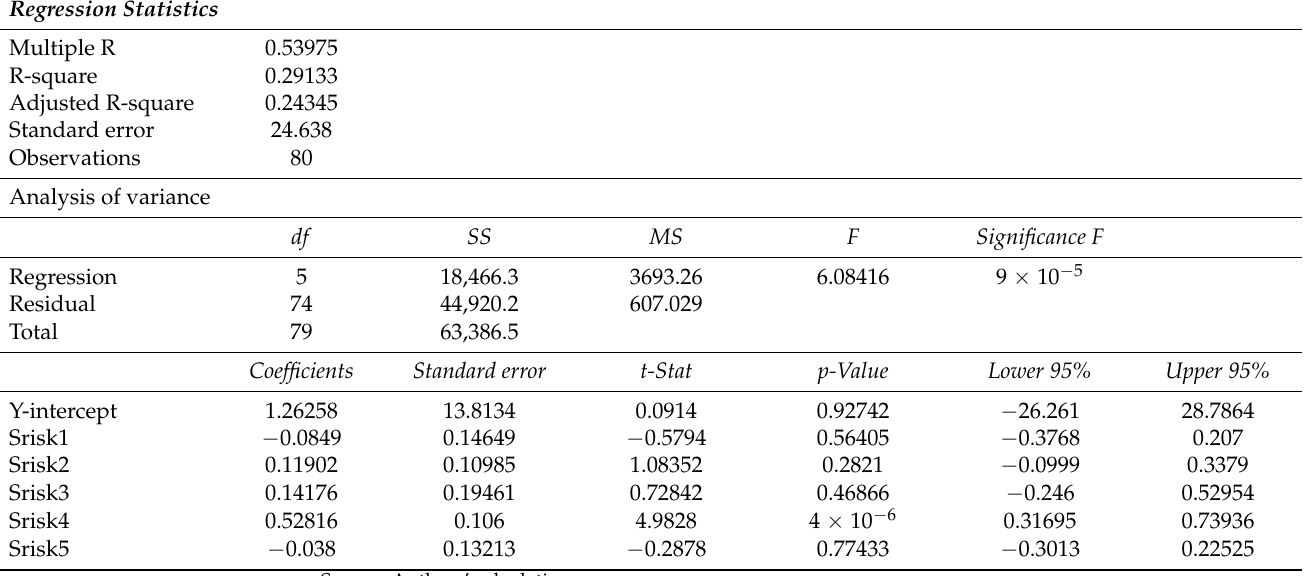
Table A11. Regression statistics of the dependence of Frisk 2 on social consequences of investments in innovation (Srisk).